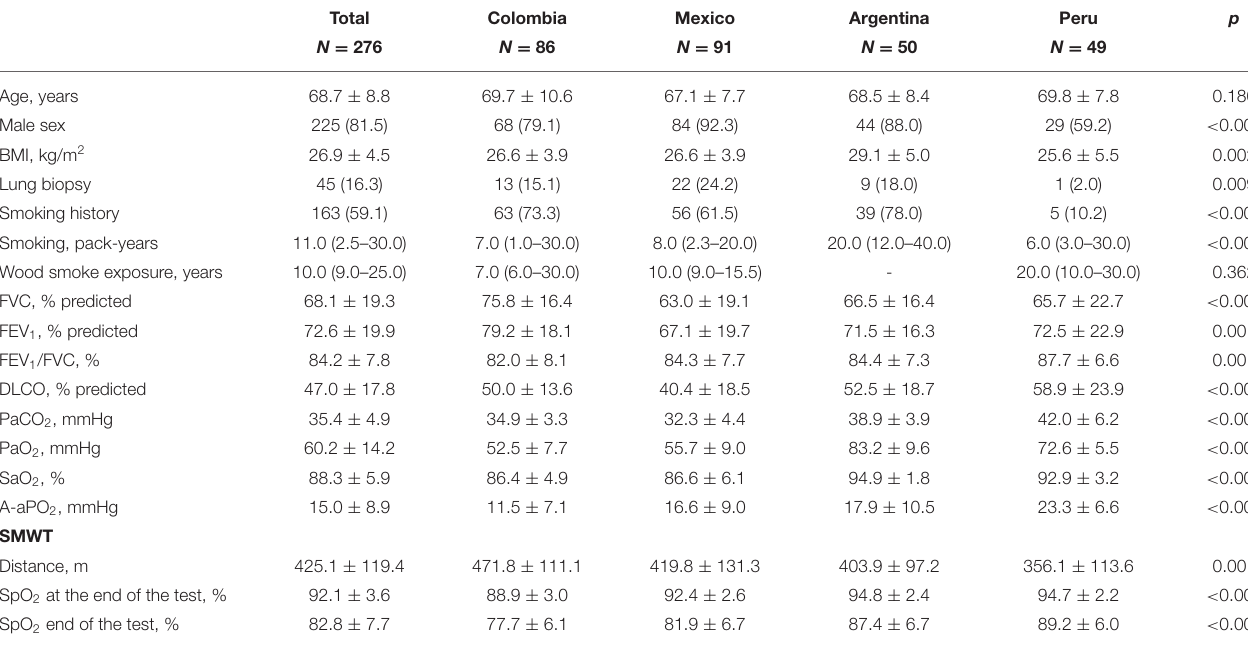
TABLE 1 | Participants characteristics and lung function tests.